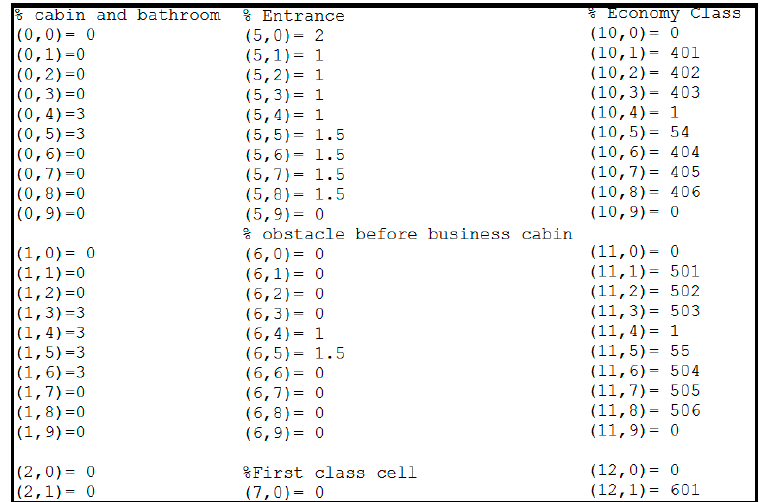
Figure 19. Initializing cell space with various values.